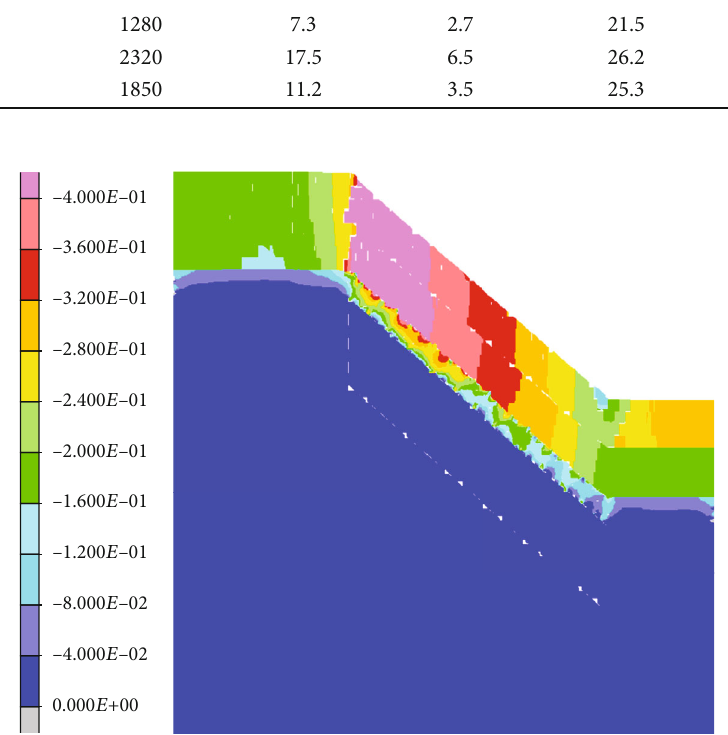
Figure 7: Displacement cloud diagram in the yy direction when running 80,000 steps.